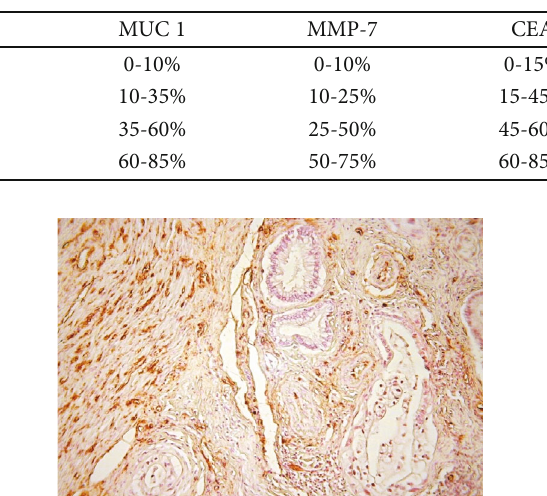
Figure 7: Pancreatic ductal adenocarcinoma, hypervascular area, immunohistochemical staining, Factor VIII, × 200.